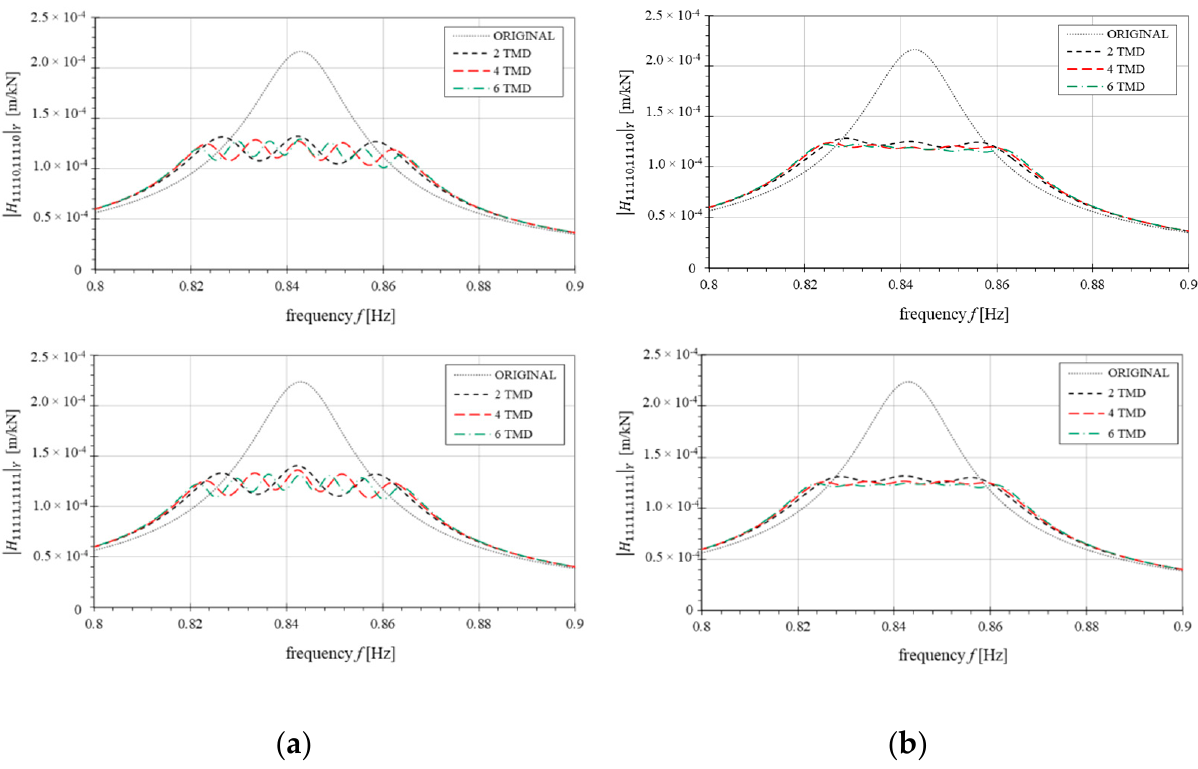
Figure 23. Module graph of a FRF in node 11,110 and 11,111 for optimal parameters and a different number of TMDs: ( a ) for the J 1 objective function; ( b ) for the J 2 objective function.